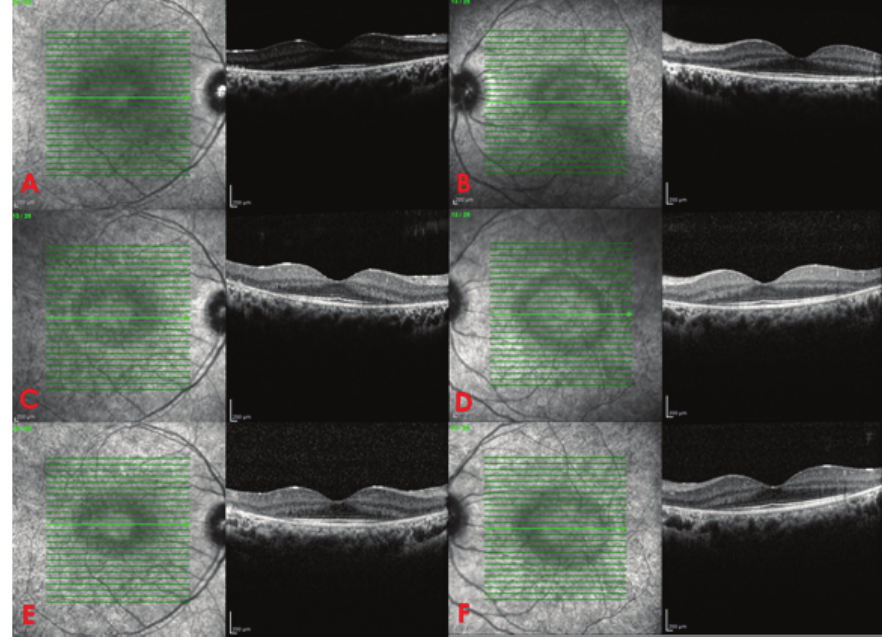
Figure 3. (A & B) Optical coherence tomography demonstrates loss of the photoreceptor layer, disruption of the ellipsoid zone, loss of the external limiting membrane, and thinning of the outer nuclear layer with central sparing at baseline. (C & D) After one- year follow-up and the last course of IVIG therapy, there is no change in retinal structures. (E & F) Six months after discontinuation of IVIG therapy (18-month follow-up), stability of retinal atrophic changes is seen.